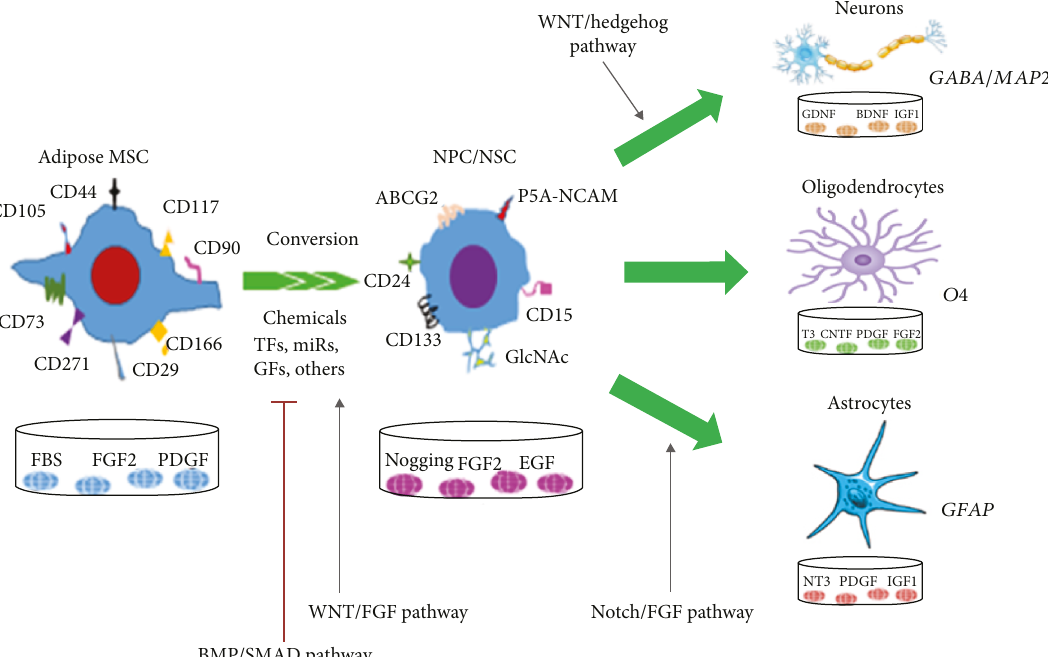
Figure 1: A schematic for the transdi ff erentiation of ADSCs into NSCs and neural cells, indicating relevant in fl uences such as cell surface markers, transcriptional factors, culture media, and signaling pathways. The details can be seen in the text. TFs: transcription factors; miRs: microRNAs; GFs: growth factors; MSCs: mesenchymal stem cells; PSA-NCAM: polysialic acid neural cell adhesion molecule; GlcNAc: N-acetylglucosamine; PDGF: platelet-derived growth factor; IGF: insulin-like growth factor; CNTF: ciliary neurotrophic factor; GABA: γ -aminobutyric acid; GDNF: glial-derived neurotrophic factor; BDNF: brain-derived neurotrophic factor; T3: 3,5,3 ′ -triiodothyronine; NT3: